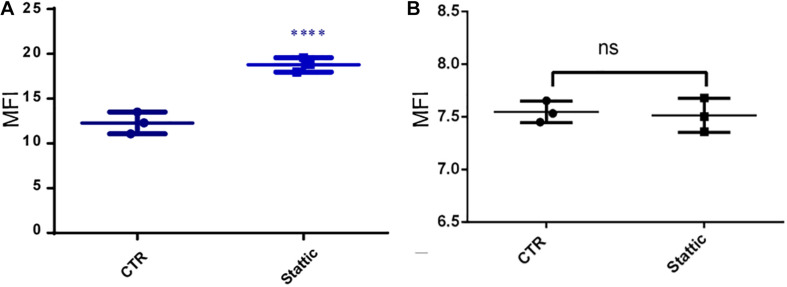
Stattic blocks DDR in MV4-11 cells. (A) MV4-11 cells pretreated with VP-16 for 2 h and then incubated in fresh culture medium with DMSO (as control) or Stattic (2.5 μM) for 4 h. The mean fluorescence intensity (MFI) of γ-H2AX was detected by flow cytometry to estimate DSBs levels in both groups (A, n = 3, ****P < 0.0001). (B) MV4-11 cells were treated with Stattic (2.5 μM) or DMSO (control) for 4 h. The MFI of γ-H2AX was detected to estimate DSB levels in both groups. There is no significant difference between the Stattic and control groups (B, n = 3. P > 0.5).